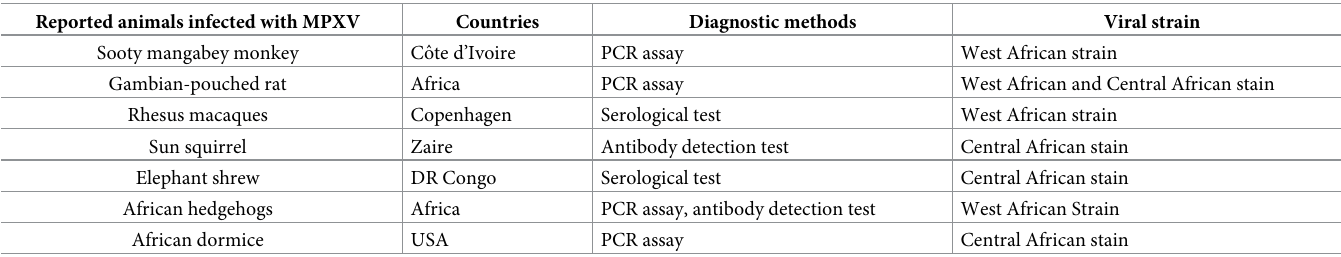
Table 1. The reported MPX-infected